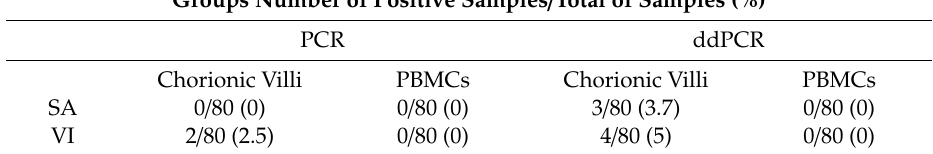
Table 1. Prevalence of human papillomavirus (HPV) DNA sequences in chorionic villi and peripheral blood mononuclear cells (PBMCs) samples from spontaneous abortion (SA) and voluntary interruption (VI) of pregnancy groups. Groups Number of Positive Samples / Total of Samples (%) PCR ddPCR Chorionic Villi PBMCs Chorionic Villi PBMCs SA 0 / 80 (0) 0 / 80 (0) 3 / 80 (3.7) 0 / 80 (0) 2 / 80 (2.5) 0 / 80